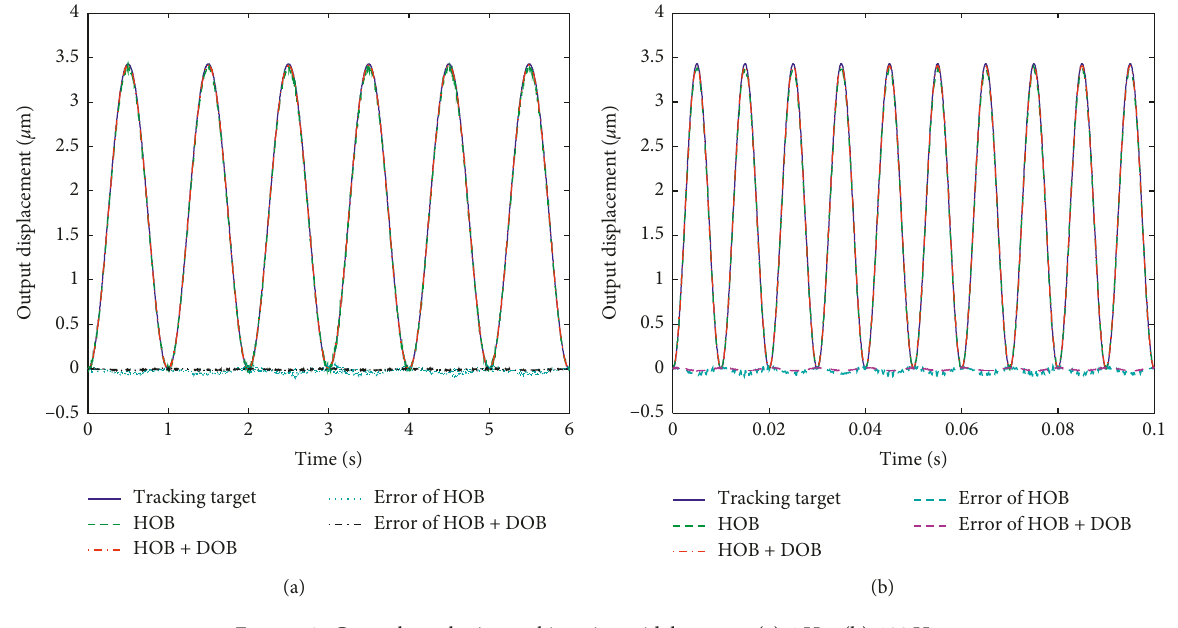
Figure 9: Control results in tracking sinusoidal targets. (a) 1Hz. (b) 100Hz. Table 2: Maximum absolute control errors of the proposed control methods.